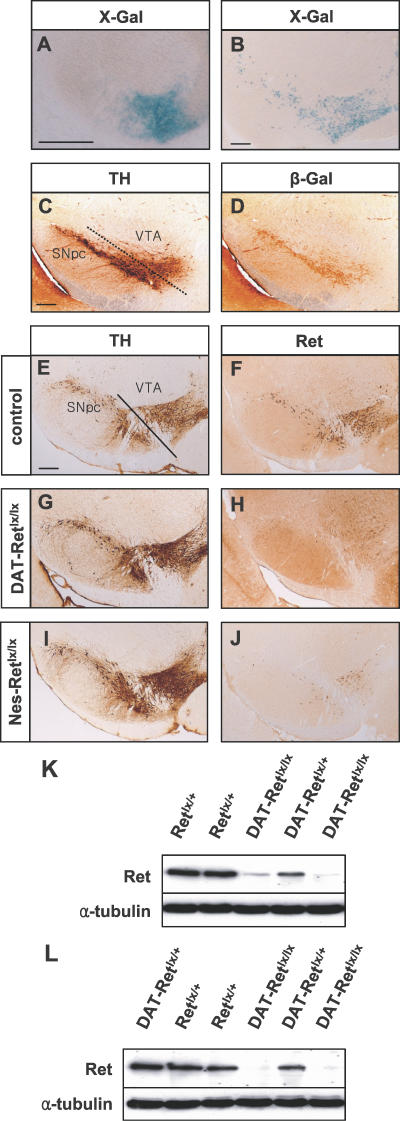
Conditional Ablation of Ret Expression in the Nigrostriatal System(A–D) Recombination efficiency of DAT-Cre mice crossed with Rosa26R lacZ reporter mice (DAT-Rosa26R). β-galactosidase (X-Gal) activity (blue) in coronal brain sections of DAT-Rosa26R transgenic mice at embryonic day E15.5 (A) and at 3-mo postnatal (B). Anti- TH (C) and anti–β-galactosidase (β-Gal) (D) immunostaining in adjacent brain sections of 2-y-old DAT-Rosa26R mice. Cre activity is restricted to SNpc and VTA.(E–J) Immunohistochemical detection of TH (E, G, and I) and Ret (F, H, and J) in adjacent coronal brain sections of 3-mo-old wild-type (wt), DAT-Retlx/lx, and Nes-Retlx/lx mice. Note the nearly complete removal of Ret immunoreactivity in SNpc and VTA of DAT-Retlx/lx and Nes-Retlx/lx mice.(K and L) Western blot analysis of Ret protein levels in protein lysates from SNpc (K) and striatum (L) of 3-mo-old control (Retlx/+and DAT-Retlx/+) and DAT-Retlx/lx mutant mice. Immunoblots were reprobed with anti–α-tubulin antibodies as loading controls.